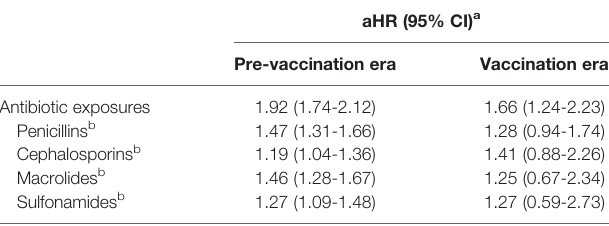
TABLE 2 | Multivariate analyses of antibiotic effects for varicella in the pre- vaccination and vaccination